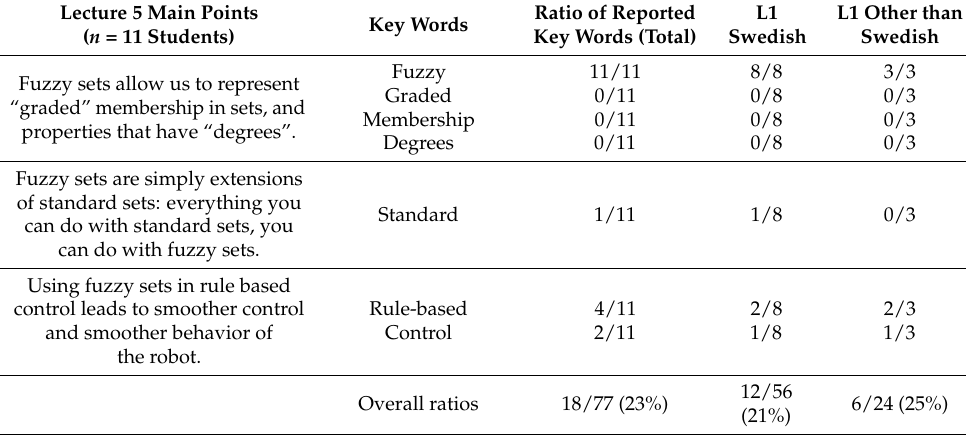
Table 6. Lecture 5 main idea key words comparison.